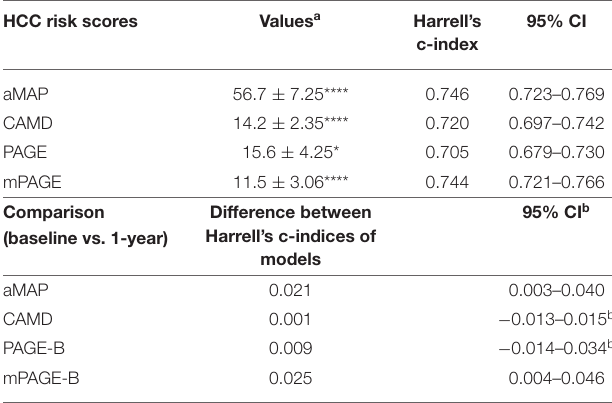
TABLE 5 | The predictive performances of HCC risk scores after 1-year antiviral